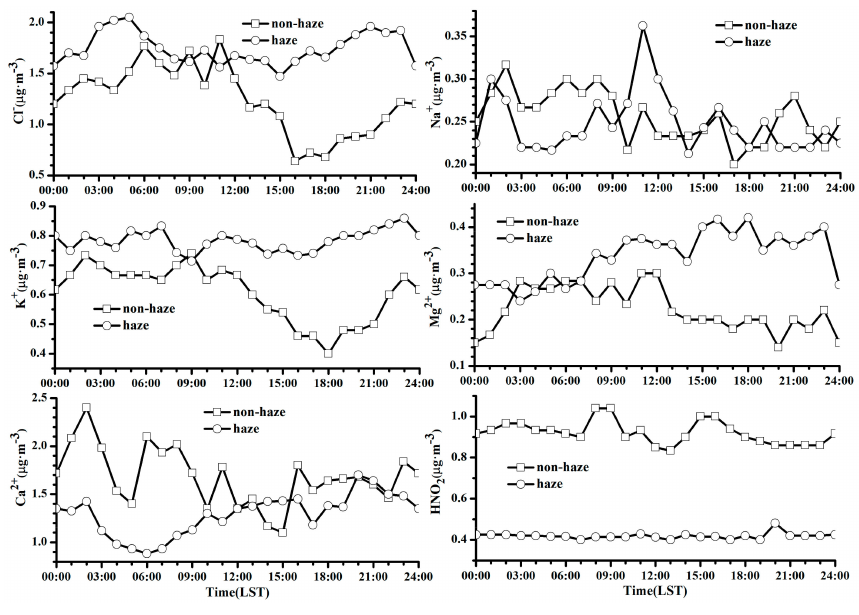
Figure 7. Diurnal variations of major WSIs.